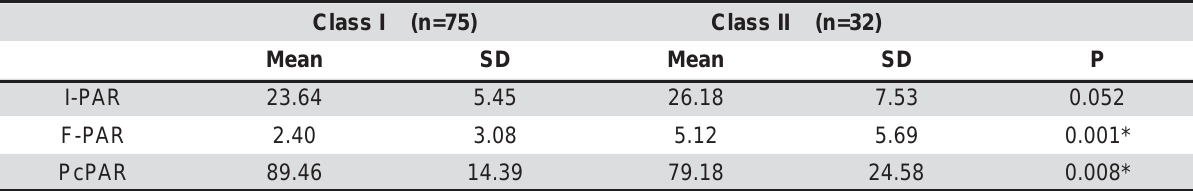
(cid:13)(cid:3)(cid:54)(cid:87)(cid:68)(cid:87)(cid:76)(cid:86)(cid:87)(cid:76)(cid:70)(cid:68)(cid:79)(cid:79)(cid:92)(cid:3)(cid:86)(cid:76)(cid:74)(cid:81)(cid:76)(cid:191)(cid:70)(cid:68)(cid:81)(cid:87)(cid:3)(cid:68)(cid:87)(cid:3)(cid:51)(cid:31)(cid:19)(cid:17)(cid:19)(cid:24)(cid:17) I-PAR=initial malocclusion severity F-PAR=occlusal treatment results